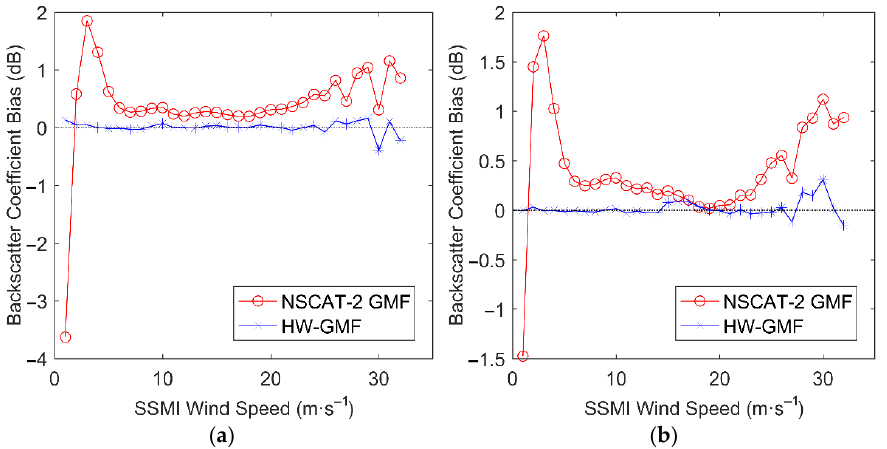
Figure 8. Dependence of the σ 0 residual on the SSM/I wind speed. The red circle in the figure is the mean value of deviation of the NSCAT-2 GMF model σ 0 minus the HY-2A measurement σ 0 , and the blue asterisk is the mean value of deviation of the HW-GMF model σ 0 minus the HY-2A measurement σ 0 . ( a ) HH polarization. ( b ) VV polarization. The dashed line in the figure represents a σ 0 bias of 0.